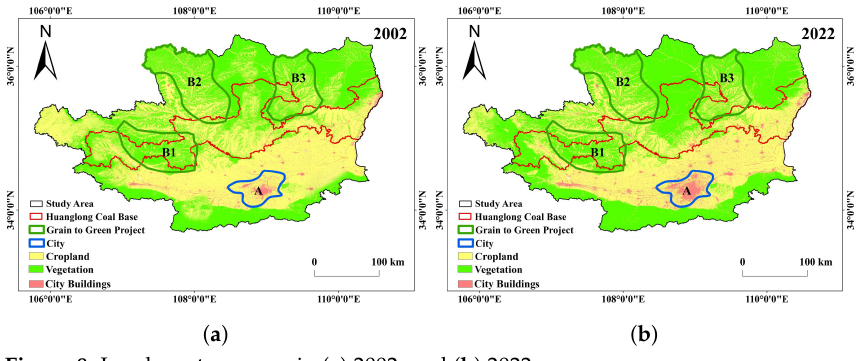
Figure 8. Land use type map in ( a ) 2002, and ( b ) 2022. Table 4. The area of upper and lower coal mining from 2005 to